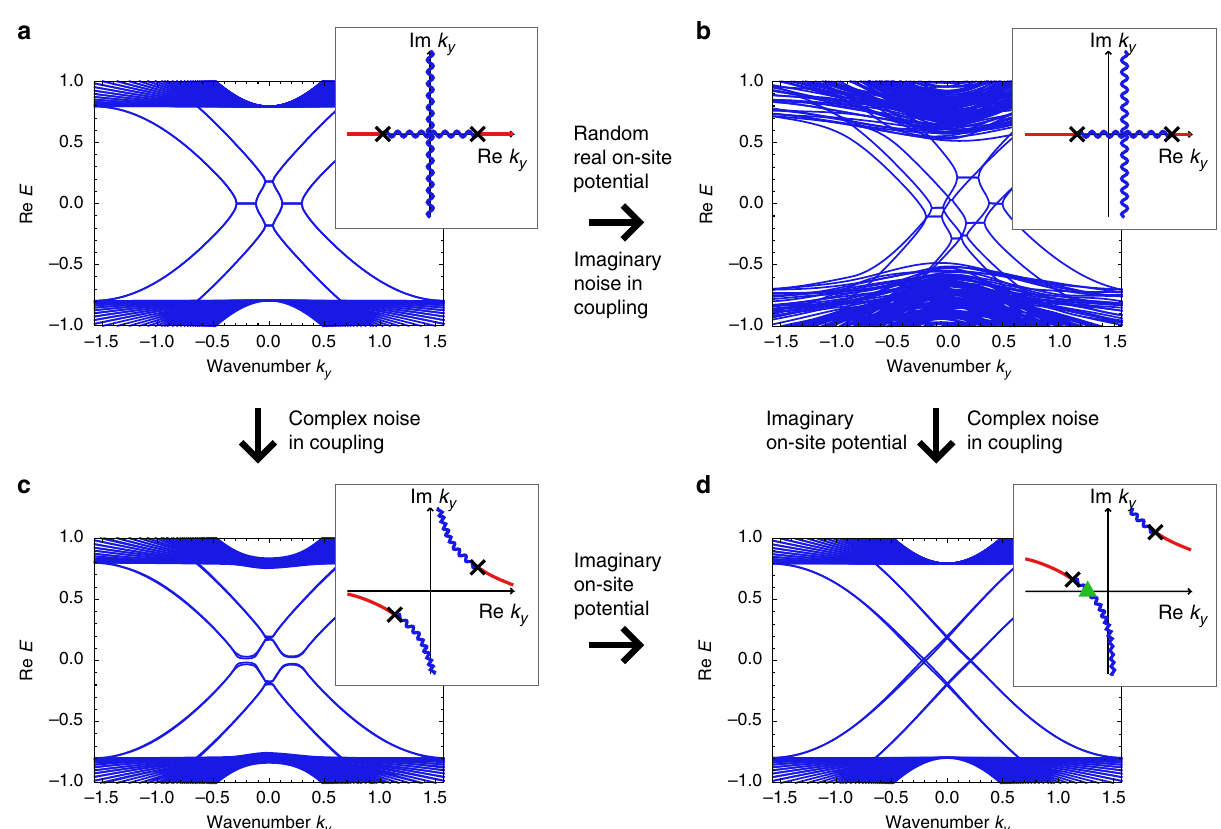
Fig. 3 Edge modes in disordered systems and their robustness. a – d Each inset shows the EPs (black crosses) and the curve of the degeneracy of the real (blue wave curves) and imaginary (red curves) parts of the edge eigenenergies in the complex wavenumber plane. Each inset corresponds to all the pairs of the edge modes with positive and negative group velocities. Because of the periodicity in the y direction, the band structure corresponds to the behavior on the Re k y axis in the insets, whereas the EPs and the degeneracy curves in the complex wavenumber space are useful for predicting the behavior of the edge modes. a The main panel shows the obtained exceptional edge modes in the system without disorder. The parameters used are u = − 1, c = 0.2, β = 0.14, β 0 ¼ 0 : 06, and γ = 0.05. b The main panel shows the edge dispersion with on-site random real potentials and imaginary disorder in the coupling term. There still exist EPs and edge modes in the bulk energy gap. The noise widths are set to be W = 0.5 ( W = 0.02) for the random real on-site potential (the imaginary noise in the non-Hermitian coupling). c The gap is opened and the edge modes no longer exist in the system with random Hermitian couplings. The noise width is set to be W = 0.1. d When we add imaginary on-site potentials, the edge modes are recovered even under the random Hermitian couplings. This is because the wavenumber should be real due to the periodic boundary condition in the y direction and the real axis of the wavenumber plane crosses the degeneracy curve for the real parts of the eigenenergies (cf. the green triangle in the inset). However, EPs disappear from the edge modes. The noise width is the same as in panel c and the strength of the on-site imaginary potential is g =